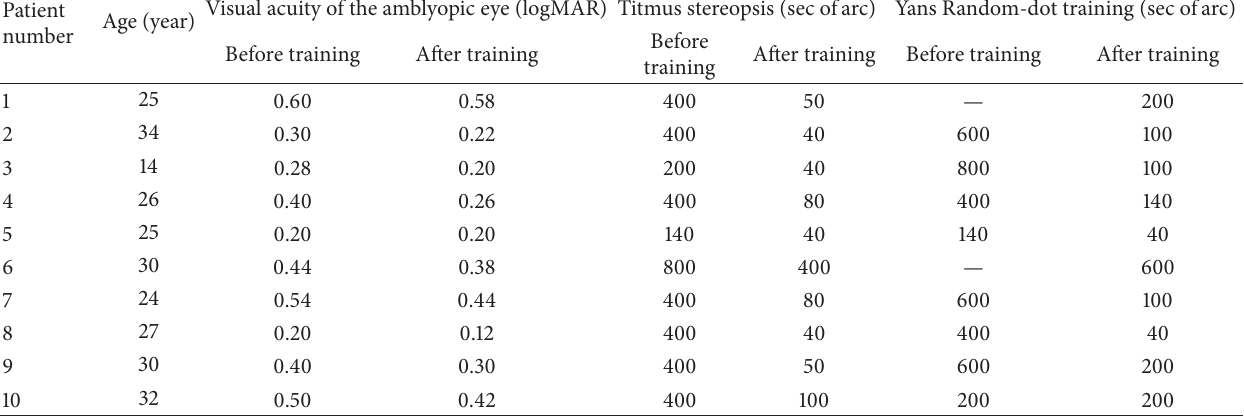
Table 1: Ten patients’ information before and after training by interocular shift of visual attention.